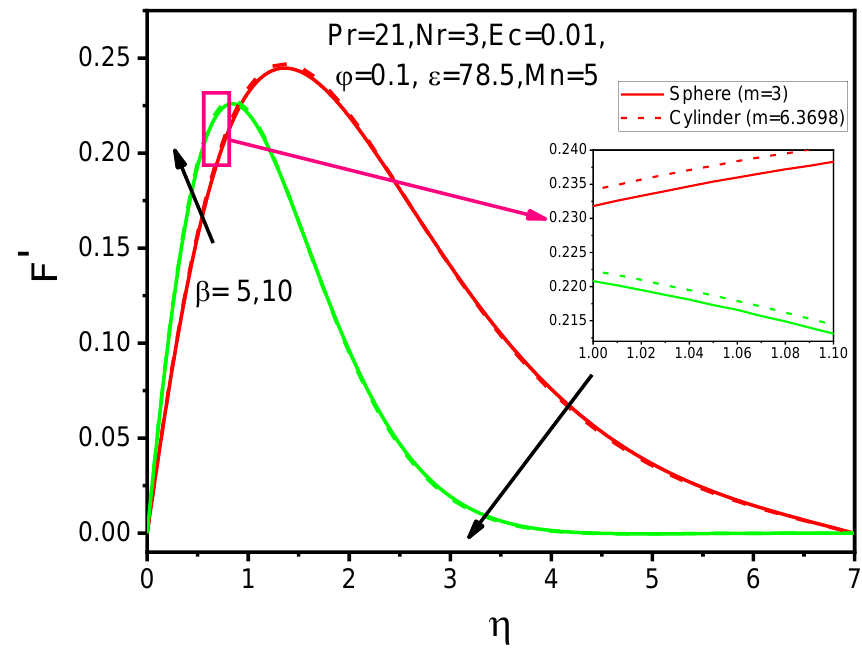
Figure 6. (Case b): Variations of F (cid:48) for β = 5,10 against η .